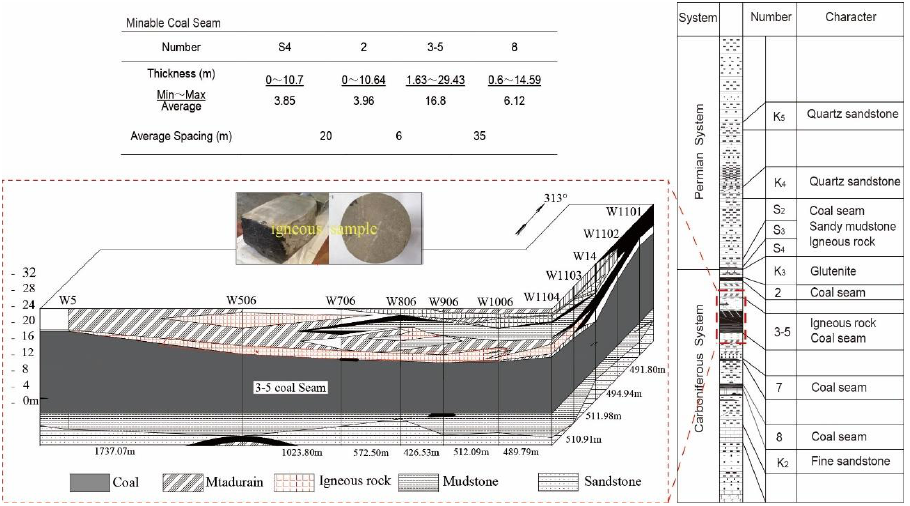
Figure 2. Geological conditions of Tashan Coal Mine.